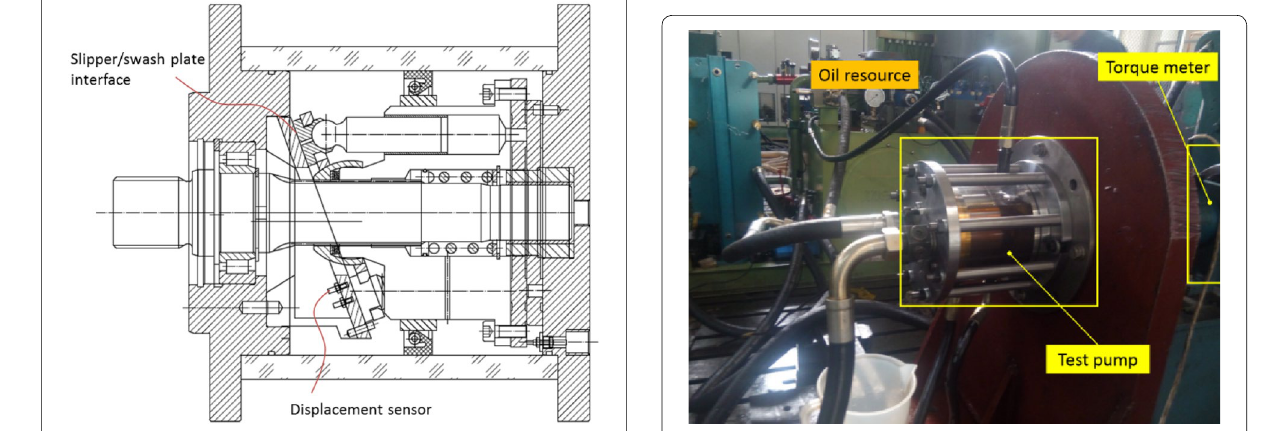
Figure 3 Photo of the test